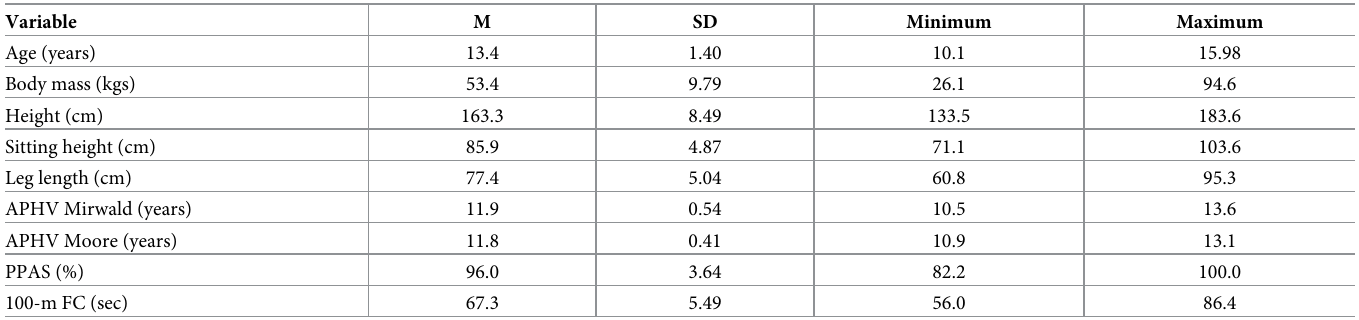
Table Notes : M = Mean; SD = Standard Deviation, kgs = Kilograms; cm = Centimetres; APHV = Age at Peak Height Velocity; Mirwald = APHV estimated via the equation developed by Mirwald and colleagues [21]; Moore = APHV estimated via the equation developed by Moore and colleagues [34]; FC = Front-crawl; PPAS = Predicted Adult Stature; sec =